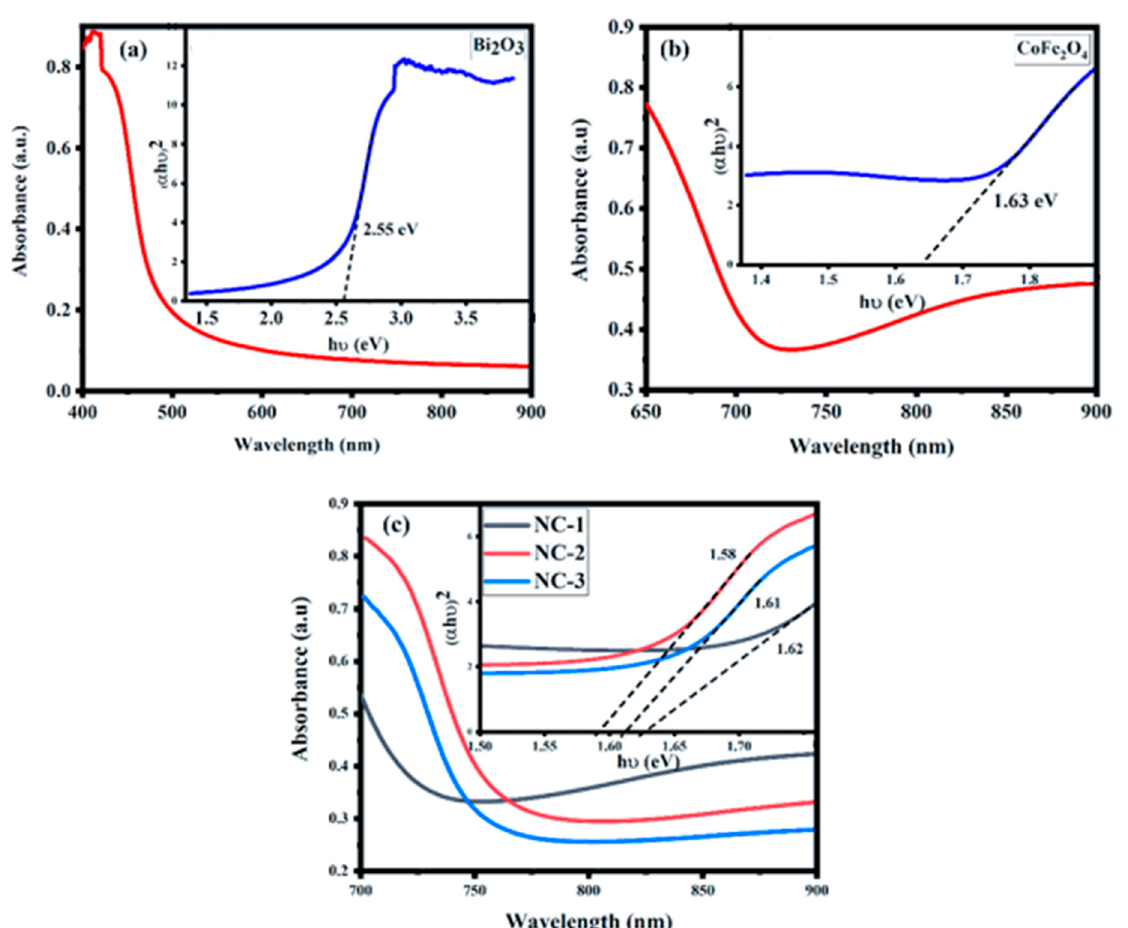
Figure 3. DRS spectra and Tauc plots of ( a ) Bi 2 O 3 ; ( b ) CoFe 2 O 4 ; ( c ) NC-1, NC-2, NC-3.